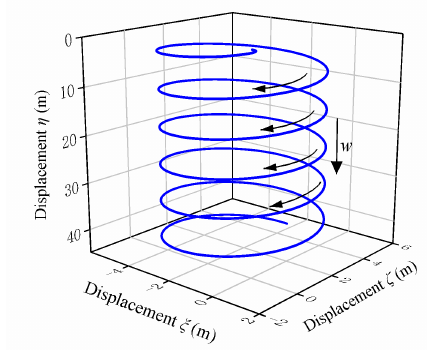
Figure 5. Spiral motion trajectory of a DTUG.